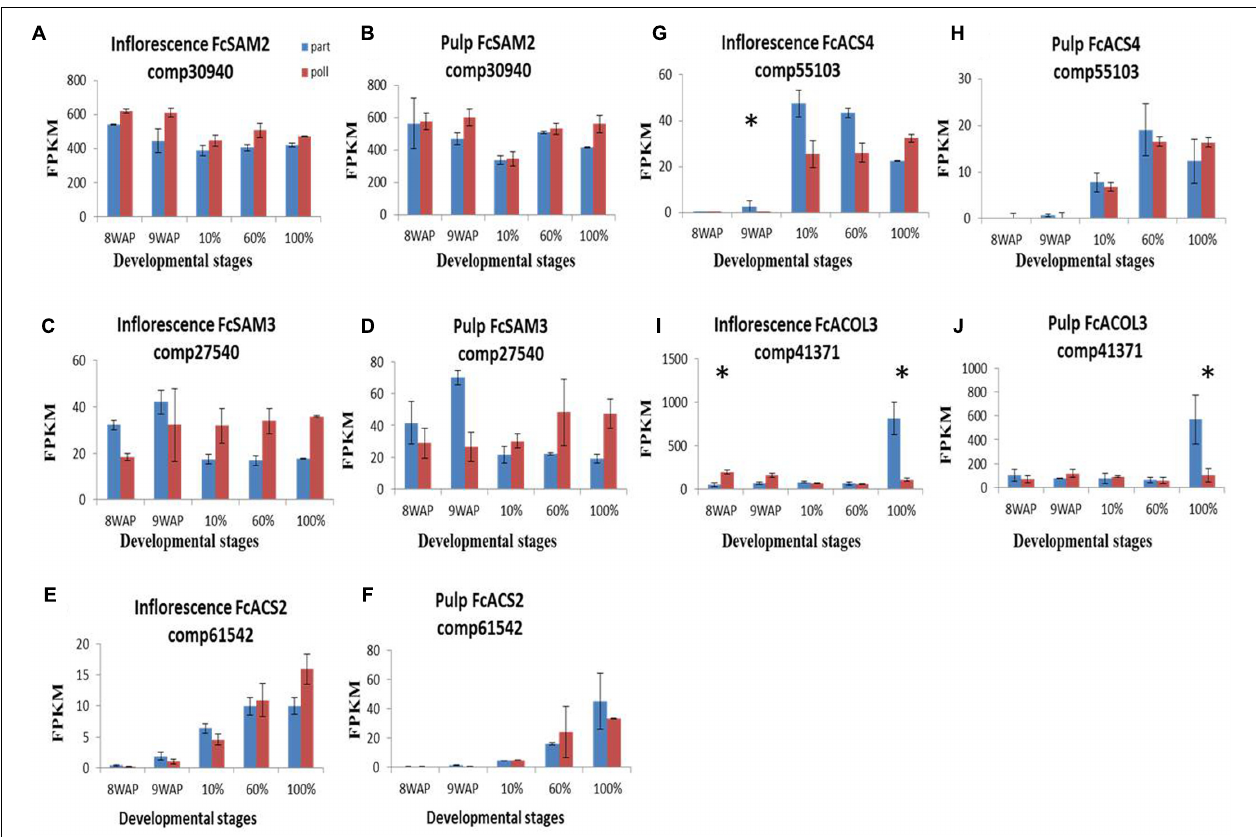
FIGURE 6 | Gene-expression pattern of six predicted ethylene-metabolism genes. Genes were identified by tblastn of the ethylene-biosynthesis genes from Arabidopsis thaliana against our Ficus carica (Fc) data and validate against Malus and the NCBI databases. (A–D) Expression levels of Fc SAM genes in inflorescence (A,C) and pulp (B,D) . (E–H) Expression levels of Fc ACS genes in inflorescence (E,G) and pulp (F,H) . (I,J) Expression levels of Fc ACOL3 in inflorescence and pulp, respectively. Bars represent standard error. Asterisk represent statistical significance determined using the edgeR test (FDR <